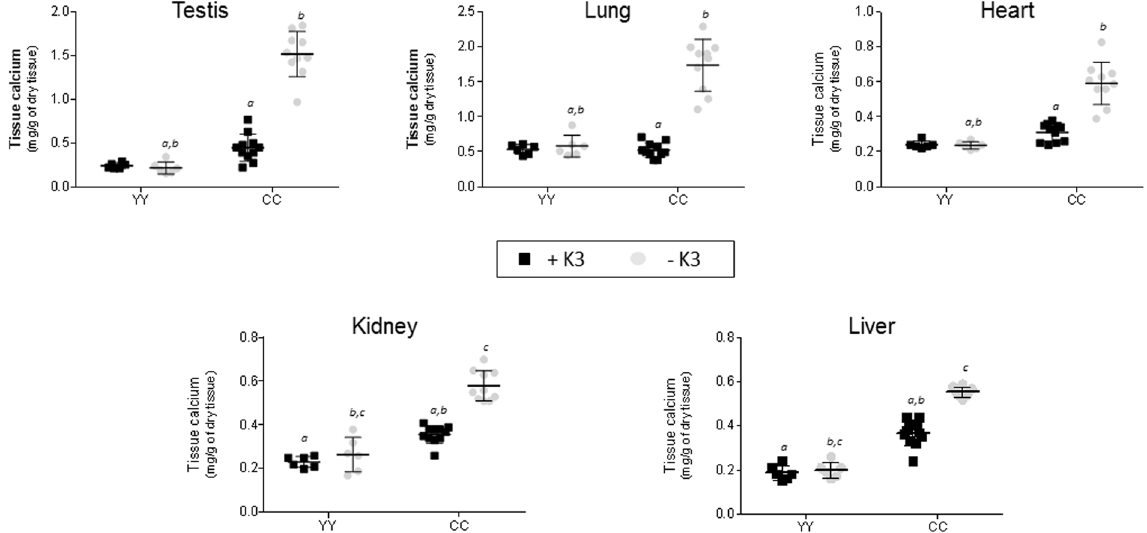
Figure 3. Tissue calcium content in testis, lung, heart, kidney and liver of 4 months old-YY or CC rats fed with standard diet (black square) or special diet –K3 (gray circle) since the weaning. Results are expressed as mean ± SD. n = 6 for groups YY and n = 11 and 10 for groups CC + K3 and CC − K3 respectively. Statistical analysis was performed using Tukey’s multiple comparisons test. Statistic difference was reported when only a unique variable between groups is modified (either genotype or diet). P < 0.01 was the accepted level of significance. a,b,c : statistical difference between 2